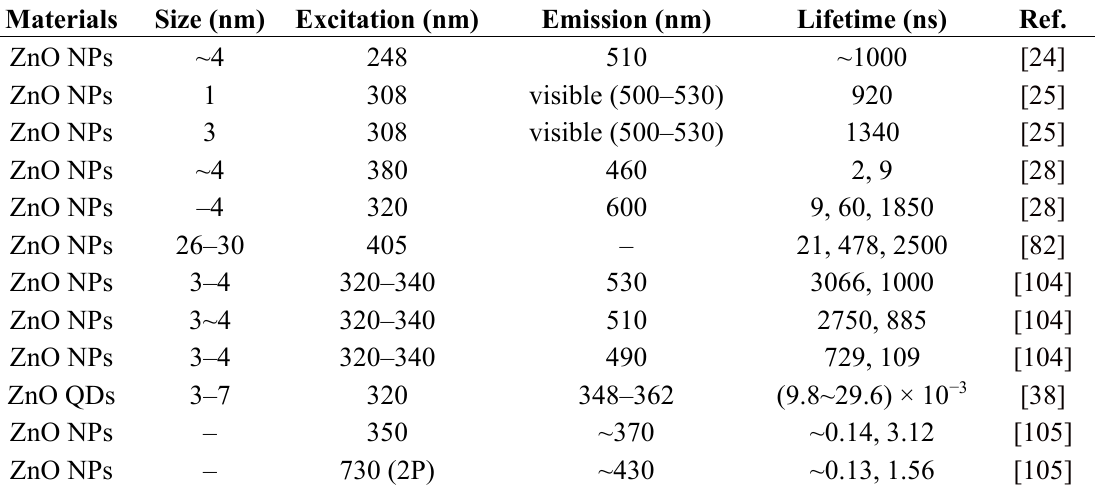
Table 5. Typical researches about the luminescence lifetime of ZnO NPs.